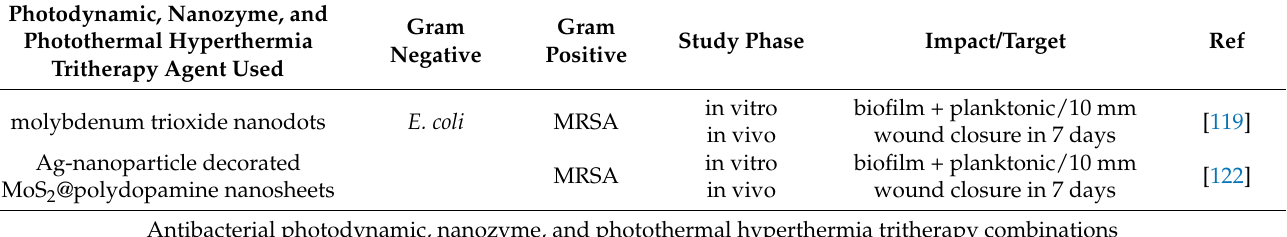
Antibacterial photodynamic, nanozyme, and photothermal hyperthermia tritherapy combinations polydopamine (PDA)-